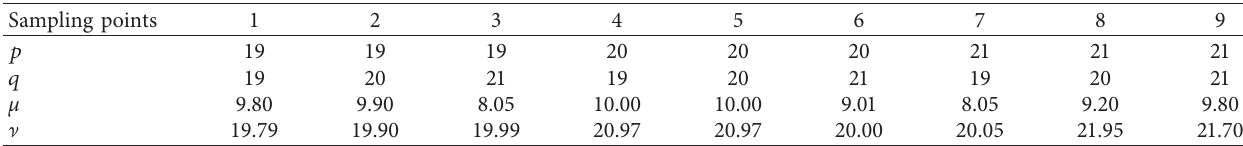
Table 1: Polarization state in the main lobe.